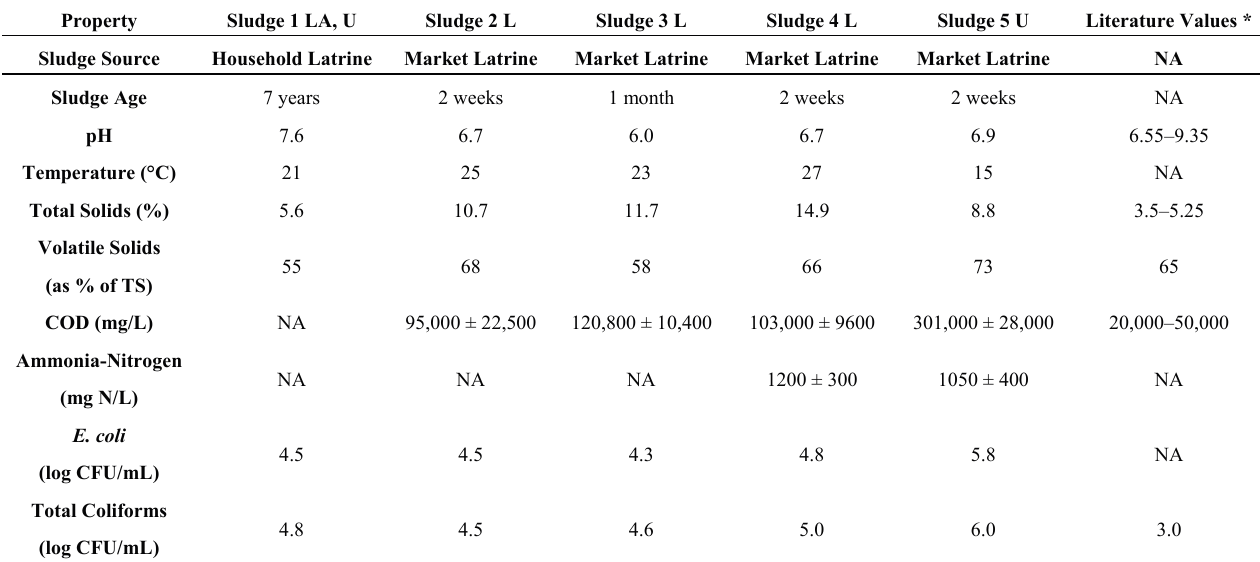
Table 1. Characteristics of initial faecal sludge used in the field